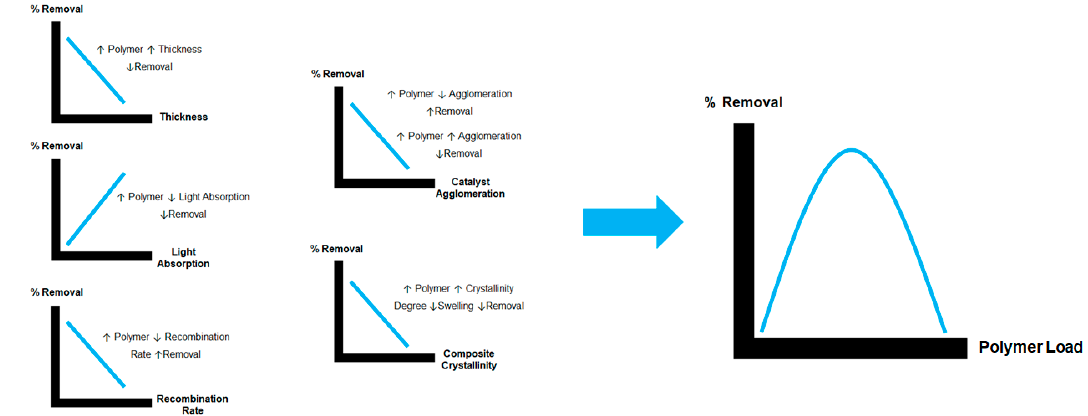
Figure 3. Effect of polymer addition on pollutant